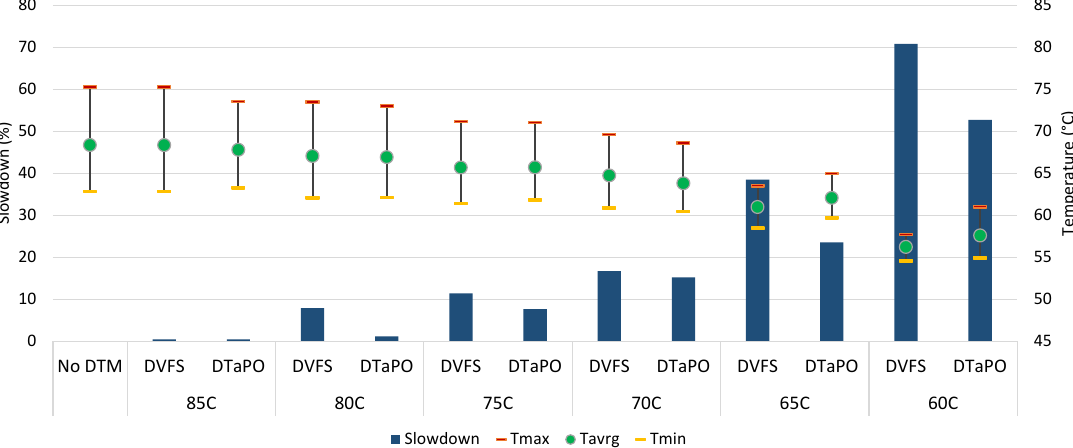
Figure 10. Performance slowdown and maximum, average, and minimum temperatures using different DTM